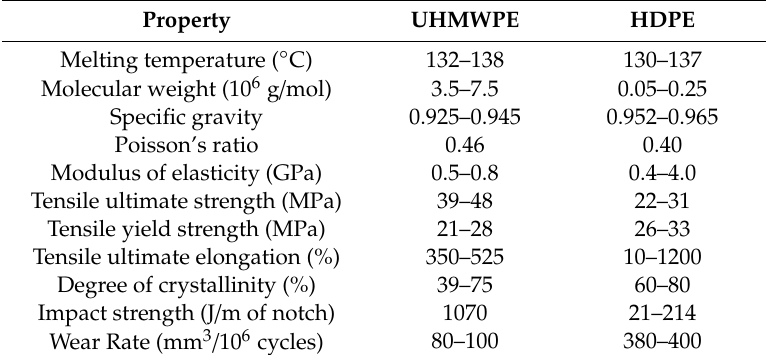
Table 1. Average properties of Ultra-High Molecular Weight Polyethylene (UHMWPE) and high-density polyethylene (HDPE). Reprinted with permission from